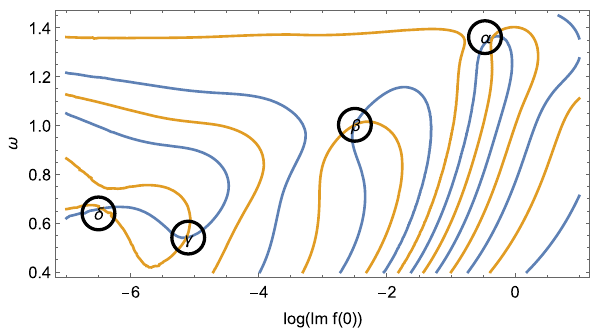
Fig. 8 The curves of vanishing real and imaginary parts of G (ω, Im f ( 0 )) for d = 4 hyperbolic case